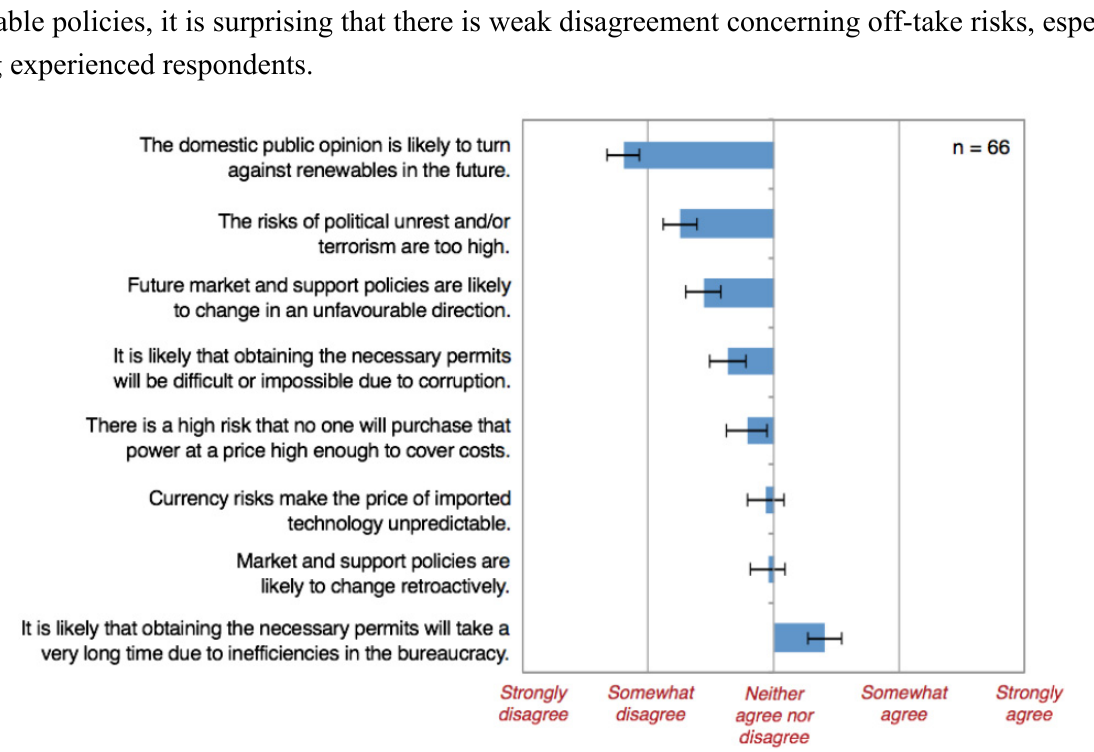
Figure 4. Results of question 3—risks to investments in renewables in the GCC